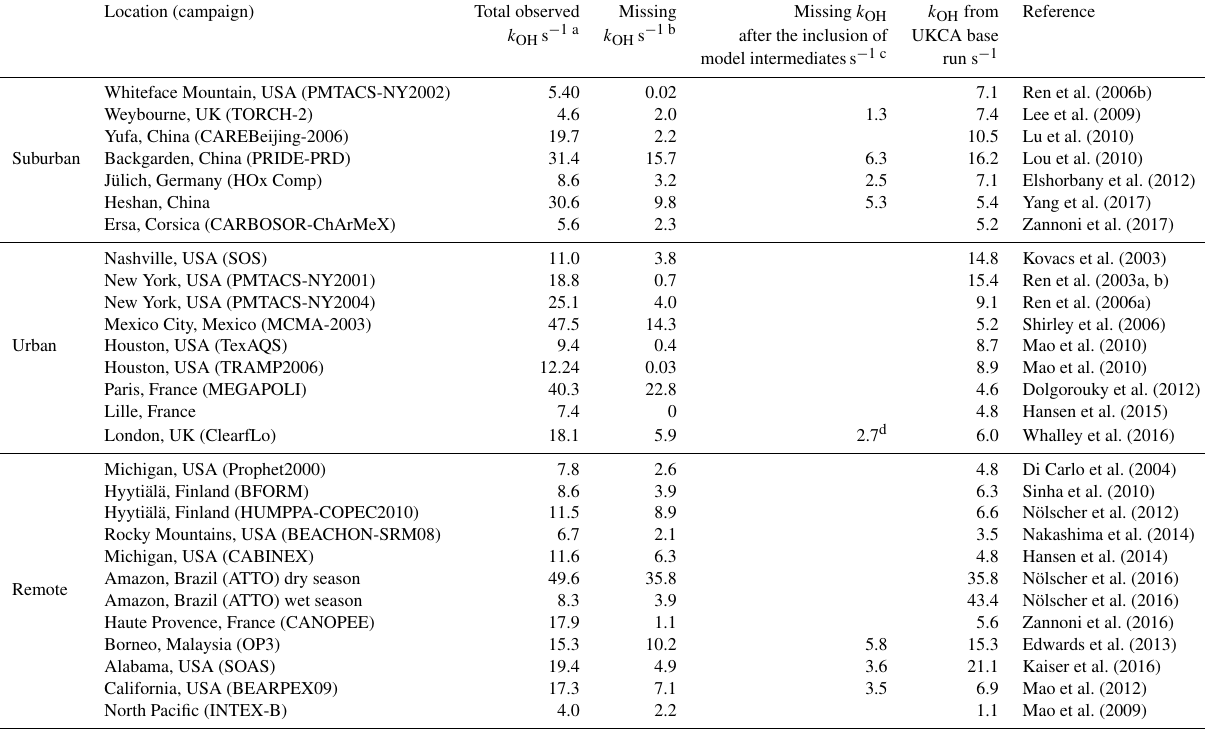
Table 2. Total observed OH reactivity and missing reactivity from field campaigns. These values represent averages over the whole duration of each campaign. Measurement sites are grouped into three categories (suburban, urban and remote environments